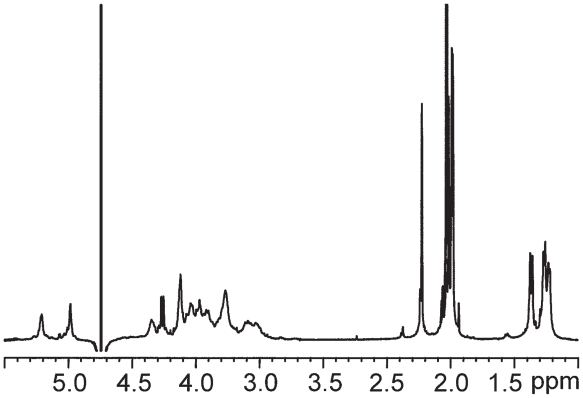
1H NMR spectrum of the O-chain polysacharide from Pseudomonas reactans.